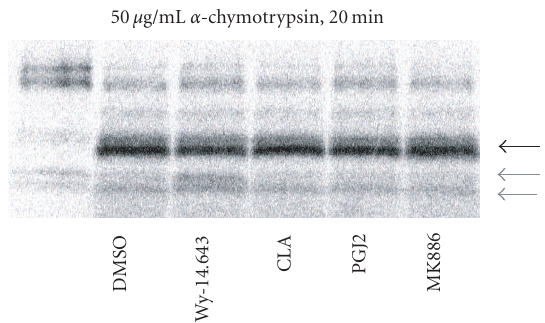
Figure 3: Protease digestion of in vitro translated PPAR α . Rat PPAR α was in vitro translated and labeled with S 35 methionine. Un- incorporated S 35 was removed with size exclusion resin and the la- beled protein was concentrated. Yield was determined and 10 fmol of PPAR α were used in each digestion. PPAR α was bound to the ligand for 30 minutes at 22 ◦ C and then digested with 50 μ g/mL of α -chymotrypsin for 20 minutes at 22 ◦ C. Resulting digests were re- solved on an 18% tris-glycine gel. The constant product is shown with the dark arrow and the Wy-14,643-protected fragments are shown with light arrows, representative of 3 independent experi-